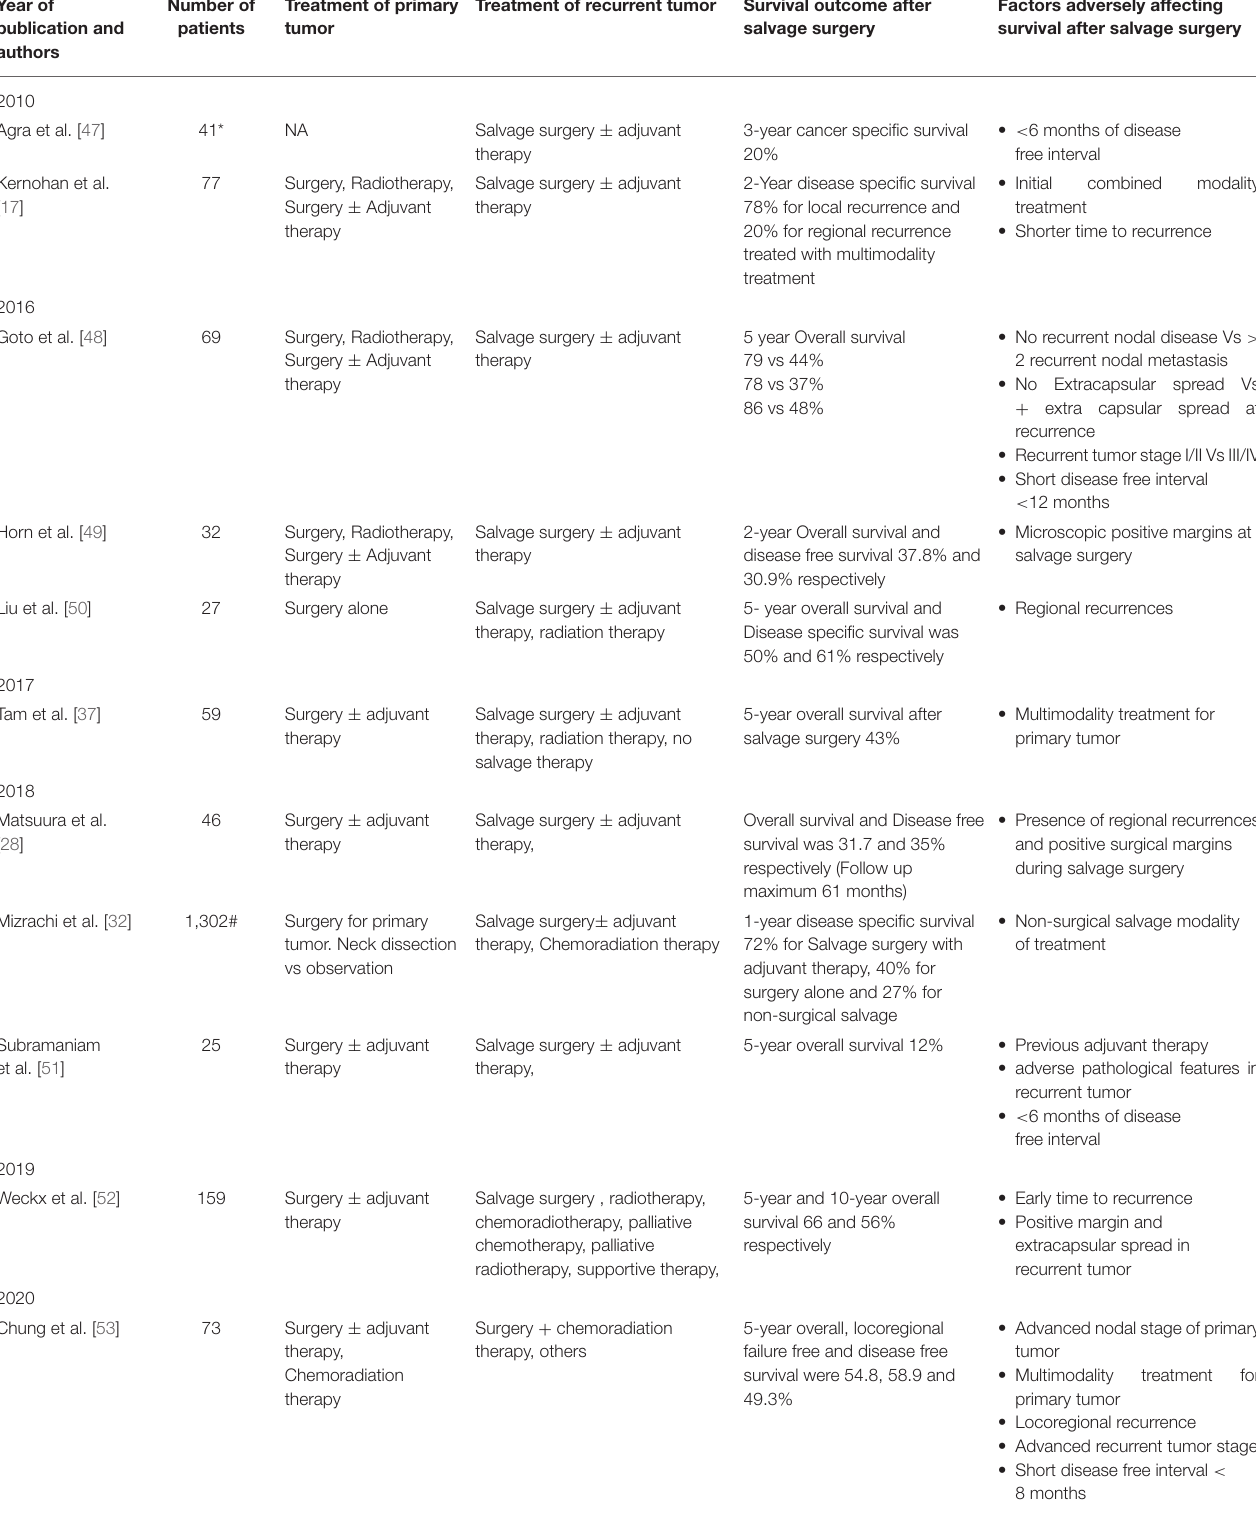
TABLE 1 | Studies evaluating survival outcomes after salvage surgery for recurrent oral cancer in the recent